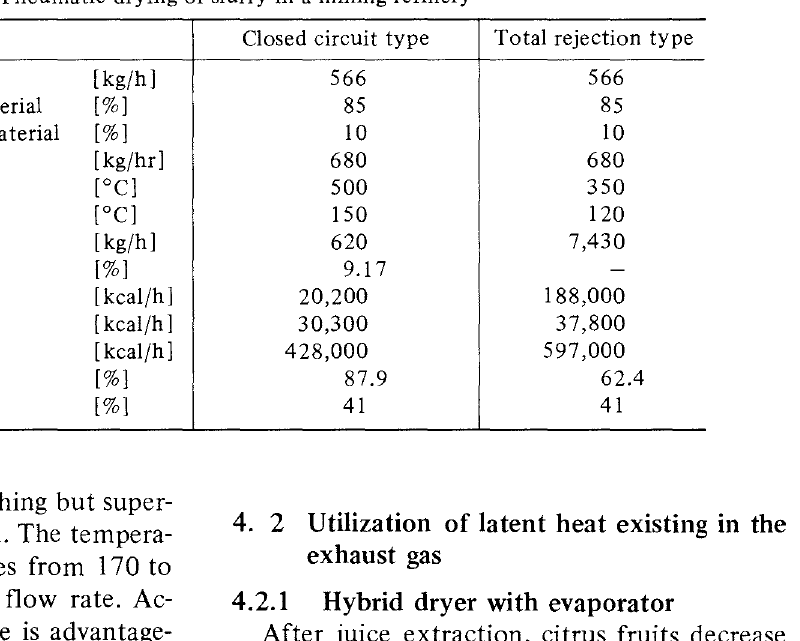
Table 28) Pneumatic drying of slurry in a mining refinery